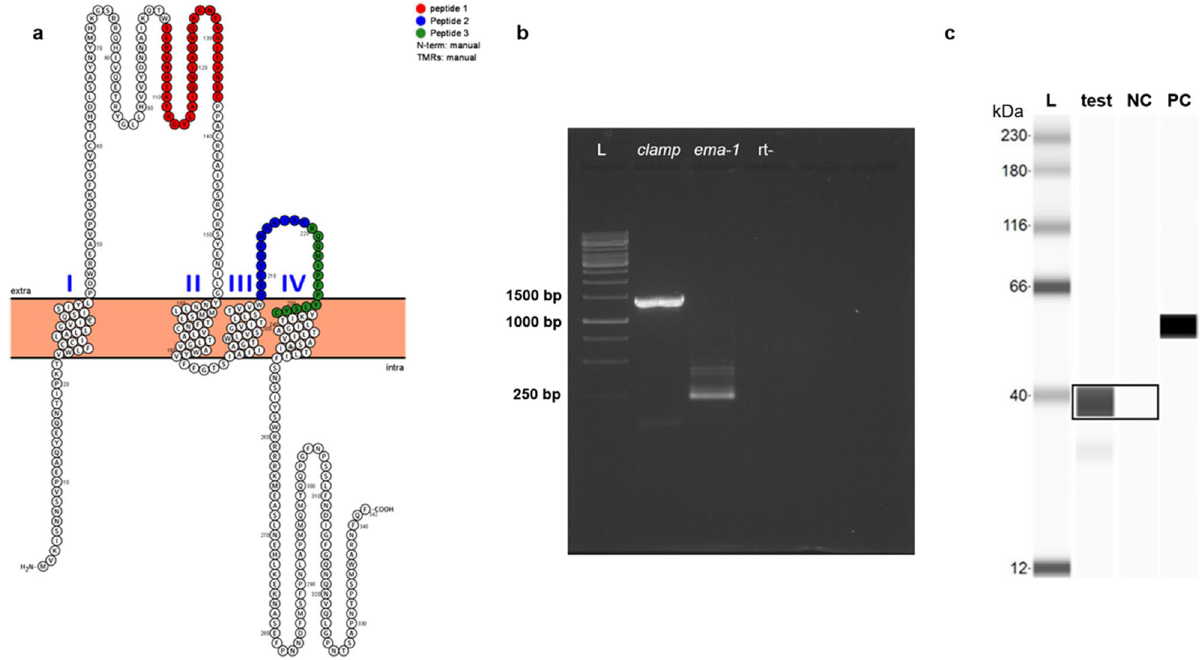
Figure 1. T. equi CLAMP contains immunogenic epitopes, and the gene is transcribed and expressed by T. equi merozoites. ( a ) CLAMP’s transmembrane topology as predicted and annotated by Phobius and Protter algorithms, respectively. Peptides 1, 2 and 3 indicate the protein’s predicted immunogenic peptides. ( b ) A 1% agarose gel showing amplified clamp transcript at ~ 1226 bp. The T. equi equine merozoite antigen-1 ( ema-1 ) transcript was amplified as a positive control, and rt- (negative control) represents amplified merozoites’ RNA without addition of reverse transcriptase. L indicates the Thermo Scientific GeneRuler 1 kb DNA Ladder. ( c ) Immunoblot showing CLAMP expressed by T. equi merozoites (test) at ~ 39 kDa. Probing of merozoites lysate with pre-immunization serum and the polyclonal anti-RAP-1a antibody were used as negative control (NC) and positive control (PC) respectively. L represents the ProteinSimple Wes